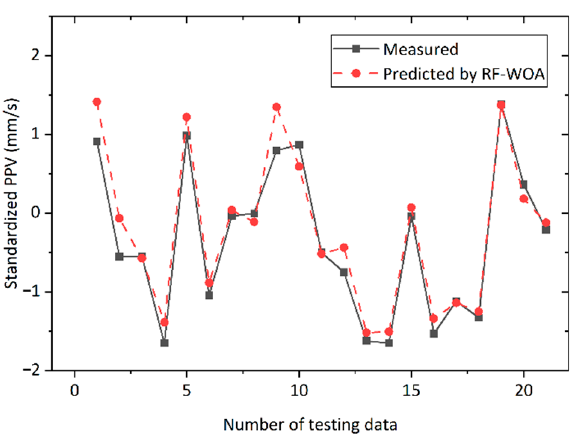
Figure 13. Measured and predicted PPV of the RF-WOA model on the testing set.